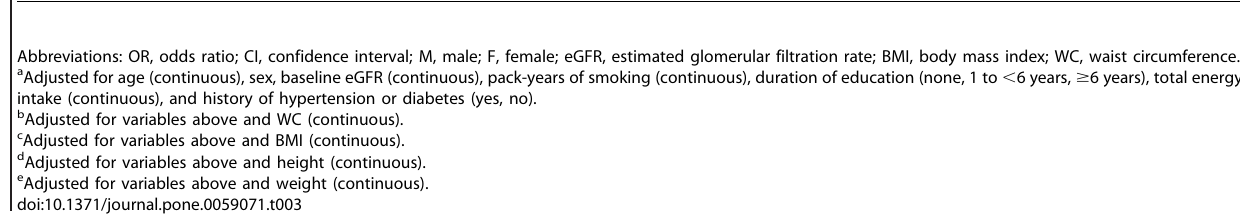
Table S1 Comparison in eGFR between participants revisit only in 2007 and those both in 2007 and